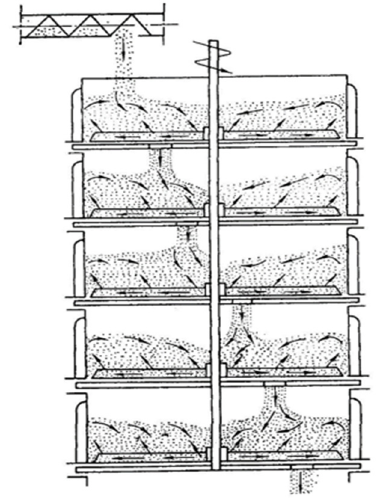
Figure 1. Scheme of continuous multi-stage heating kettle.